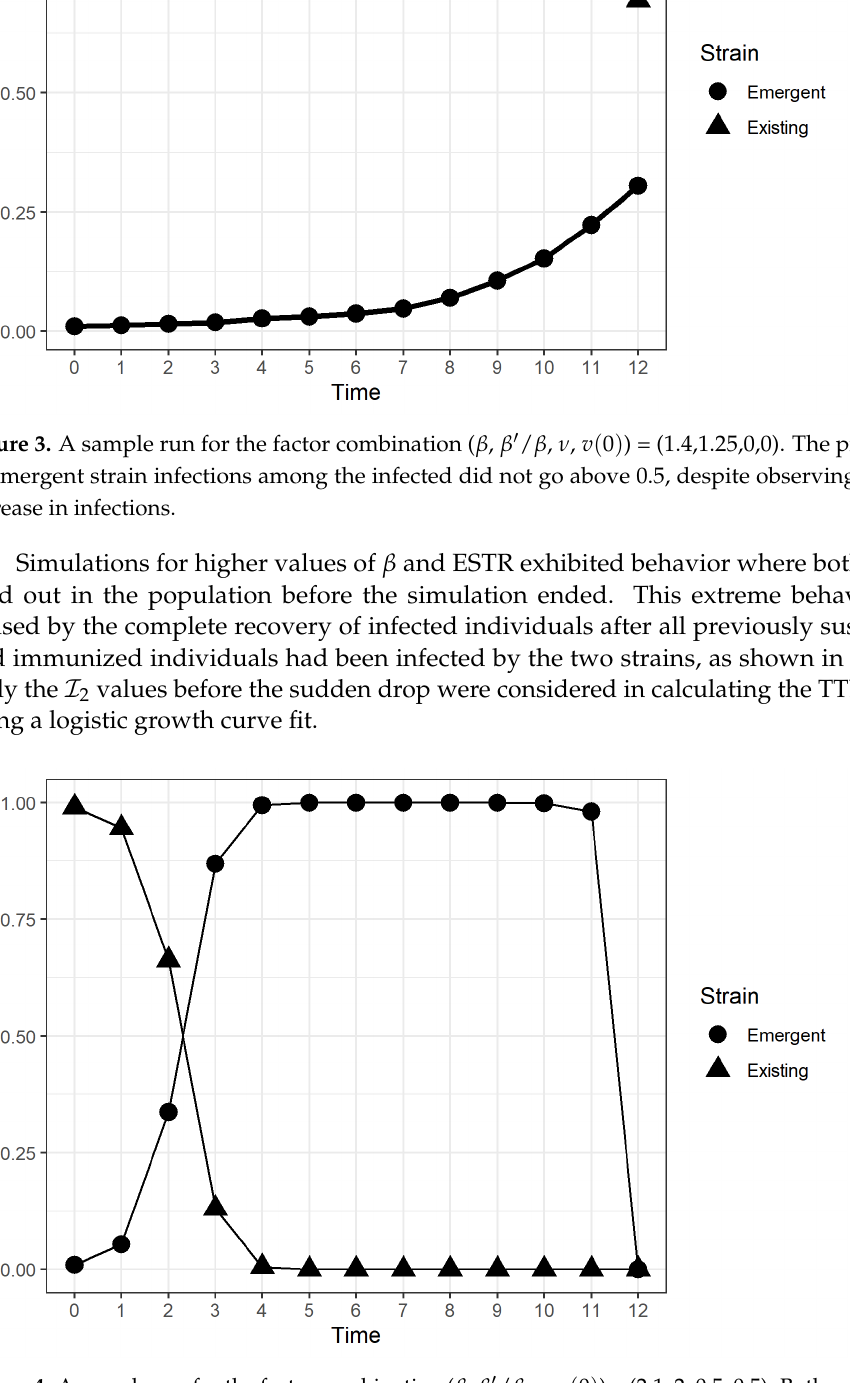
Figure 4. A sample run for the factor combination ( β , β (cid:48) / β , ν , v ( 0 ) ) = (2.1, 2, 0.5, 0.5). Both proportions dropped to zero at time t = 12, due to complete recovery after complete infection of all infected individuals in the